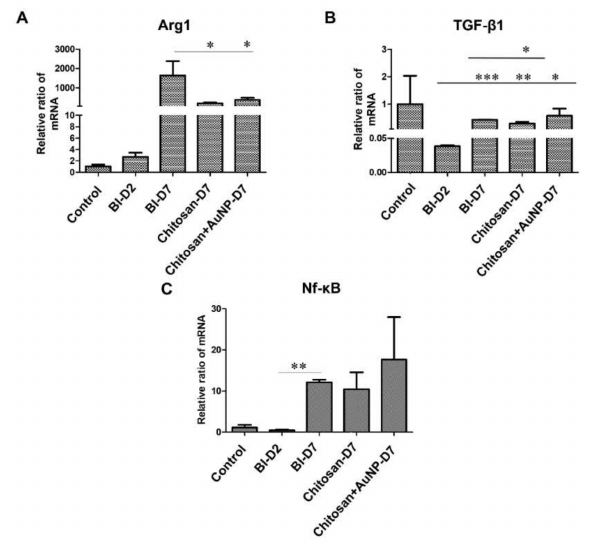
Figure 8. The relative mRNA expression level of several inflammation biomarkers in rat burn wound tissues from the control, lesion, chitosan dressing, and AuNP-coated chitosan dressing groups. ( A ) Arg1; ( B ) TGF- β 1; ( C ) Nf- κ B. Control = normal control group; BI D2 = lesion control group day 2 post-wounding; BI D7 = lesion control group day 7 post-wounding; Chi D7 = chitosan dressing treatment day 7 post-wounding; Chi + AuNP30 D7 = AuNP-coated chitosan dressing treatment day 7 post-wounding; * p < 0.05, ** p < 0.01, *** p < 0.001.